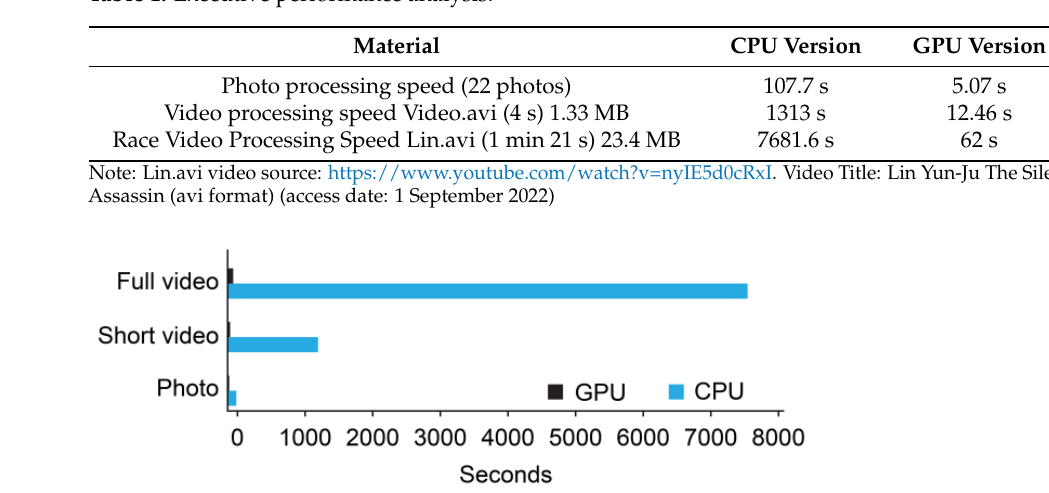
Table 1. Executive performance analysis.